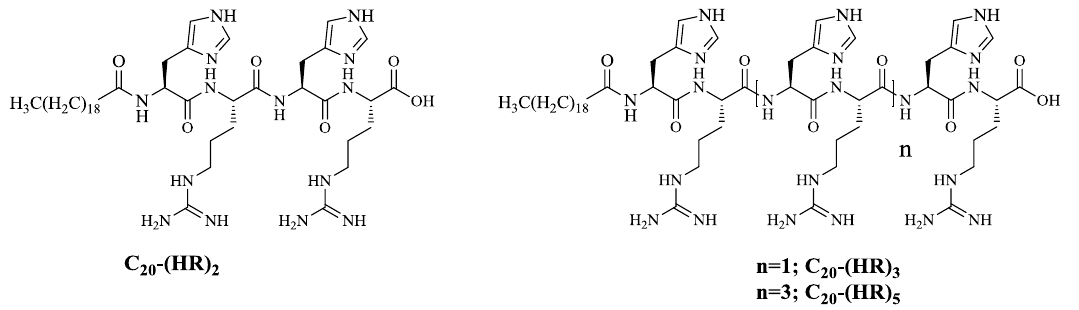
Figure 1. Chemical structures of C 20 -(HR) 2 , C 20 -(HR) 3 , and C 20 -(HR) 5 .